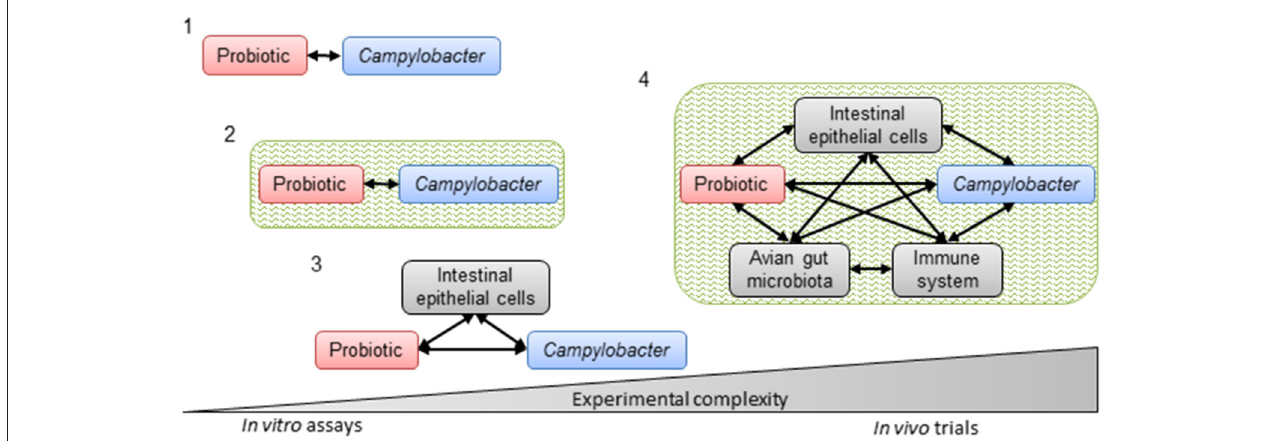
FIGURE 4 | Progressive complexity of methods used to select probiotics with in vitro and in vivo anti- Campylobacter activity. Simplified in vitro assays to assess direct interactions between the probiotic and Campylobacter (1) without (co-culture and agar plate diffusion) or (2) with an intestinal environment (co-culture in batch) or (3) interactions between the probiotic, Campylobacter and intestinal epithelial cells (adhesion and invasion assays). Complex in vivo trials (4) with their potential interactions to corroborate in vitro assays. Black arrows represent potential interactions. Green represents the intestinal